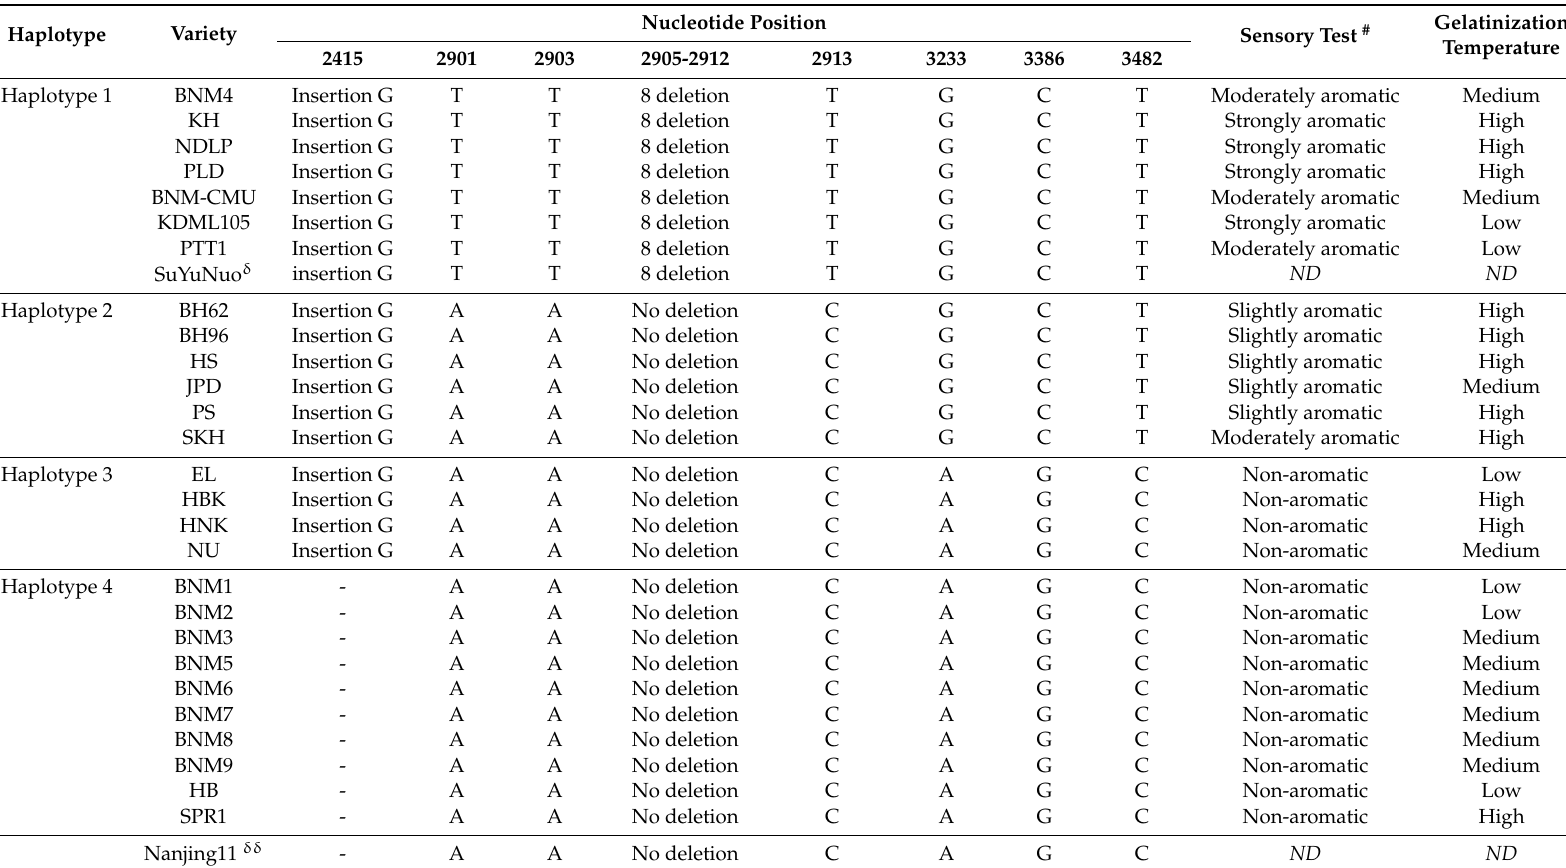
Table 4. Nucleotide sequences of Badh2 / badh2 allele on exon 7, sensory test and alkaline test of 22 landrace fragrant rice varieties, 2 breeding line varieties, and 3 check